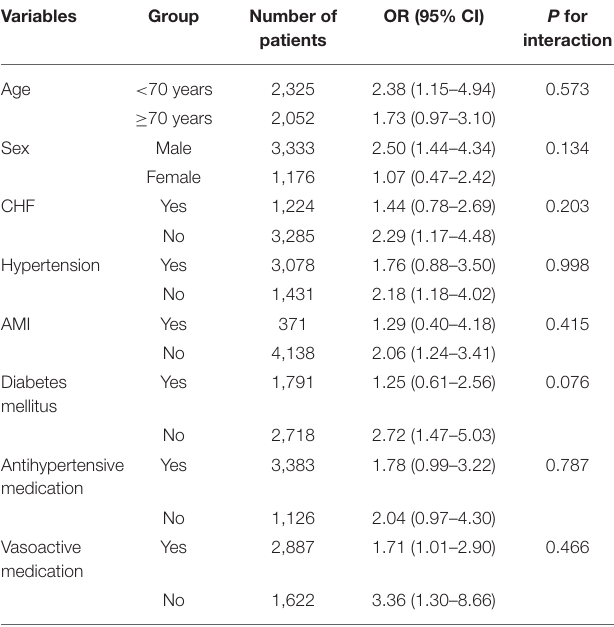
TABLE 3 | Risk of 30-day mortality for the highest quartile (Q4) vs. Q1–3 for the coefficient of variation of SBP in different subgroups.